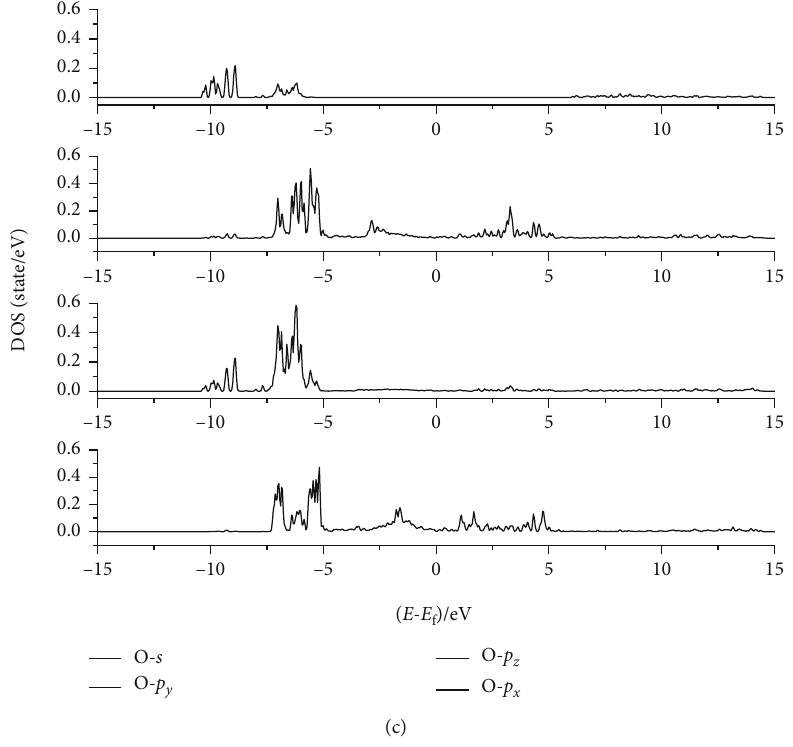
Figure 3: PDOS of Ni, C, and O atoms after CO absorption: (a) Ni atom; (b) C atom; (c) O